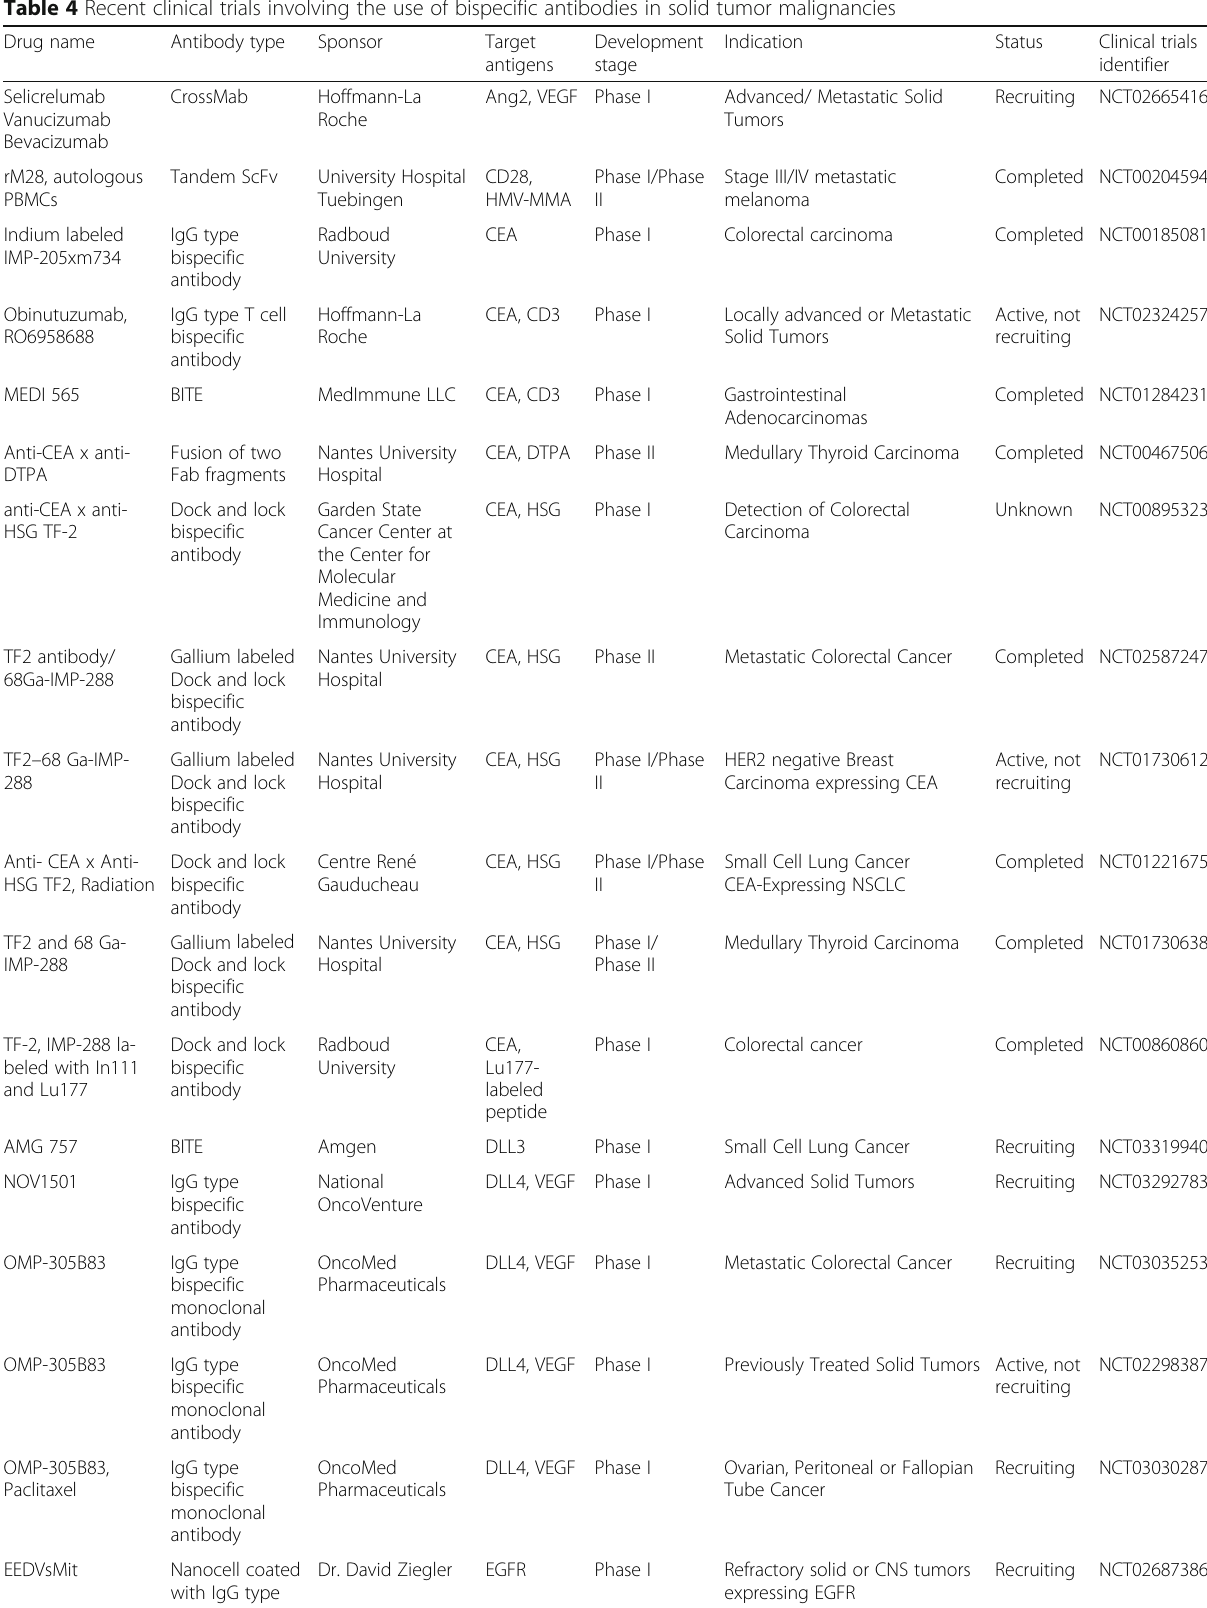
Table 4 Recent clinical trials involving the use of bispecific antibodies in solid tumor